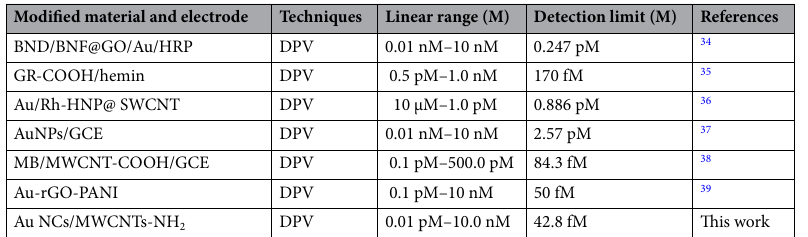
Modified material and